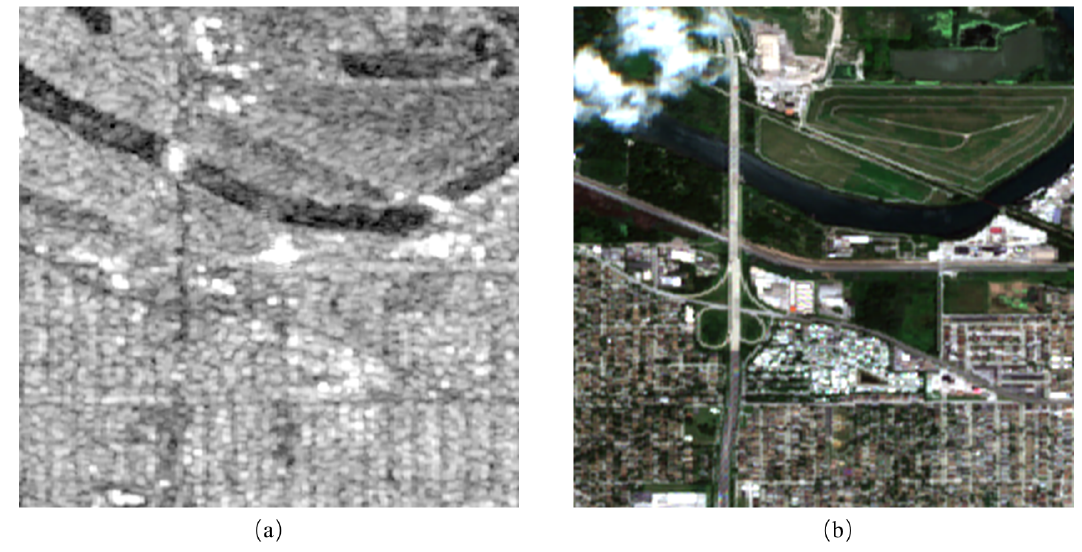
Figure 1. The comparison between ( a ) SAR image and ( b ) optical image. Best viewed in